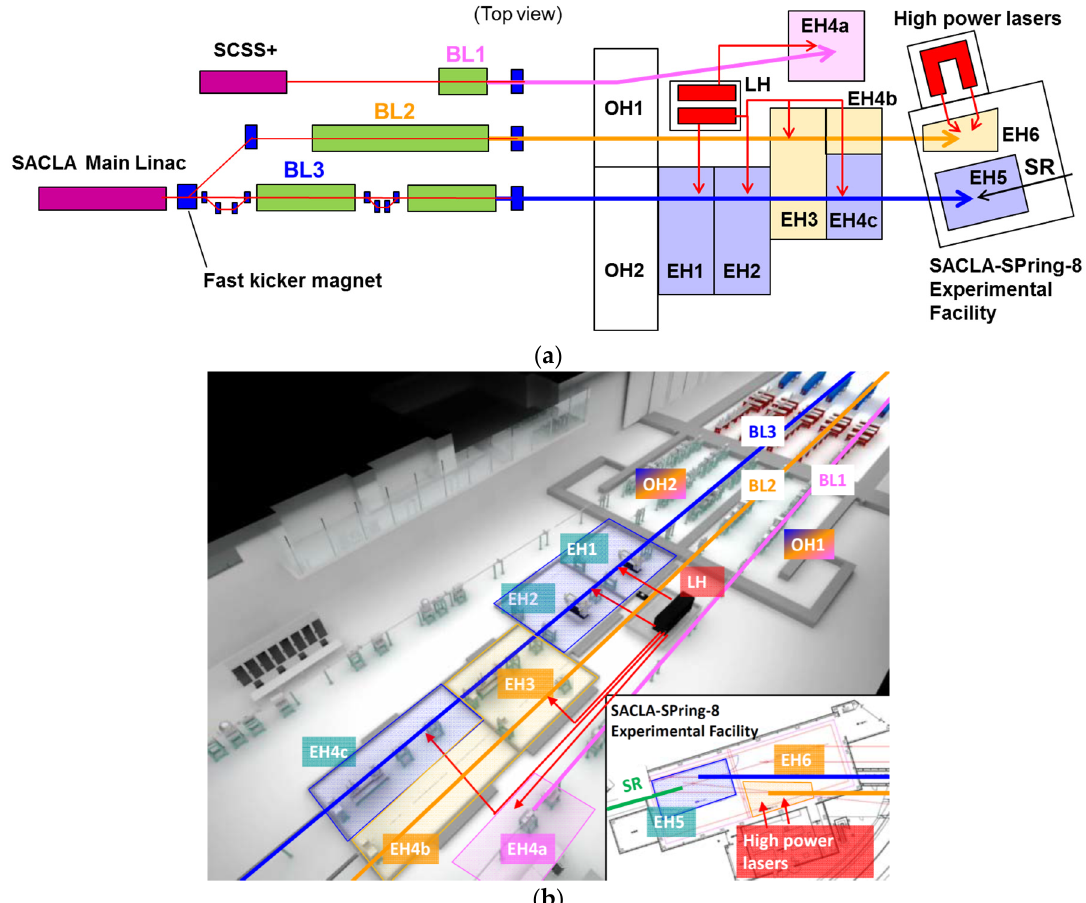
Figure 3. ( a ) Schematic top view of the SACLA facility. Purple bars in ( a ) indicate linacs and green bard indicate undulators. OH: optics hutch; EH: experimental hutch; LH: laser hutch; SR: synchrotron radiation from SPring-8. ( b ) Schematic bird’s eye view of the SACLA experimental hall.